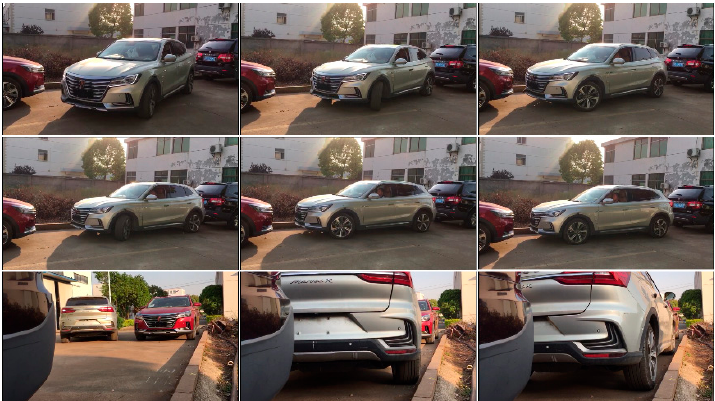
Figure 25. Photos of Automatic Parking Test.